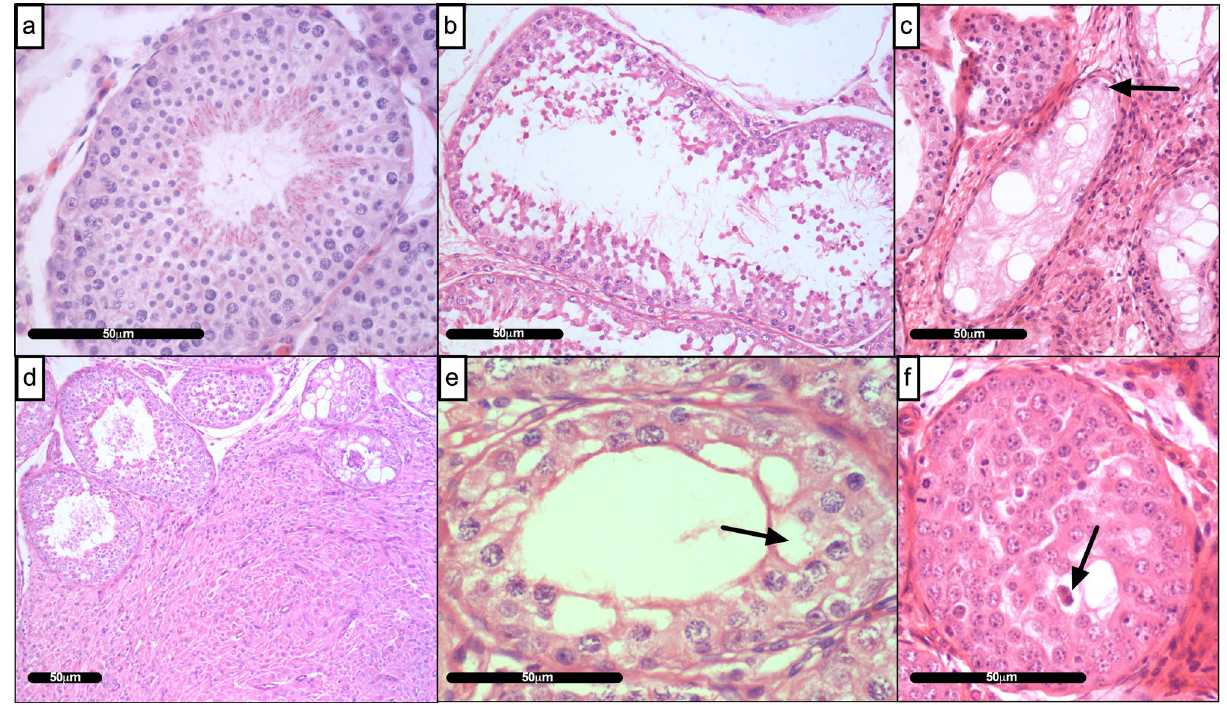
Figure 1. Histopathological features of dog testes. ( a ) Normal seminiferous tubule ( b ) Degeneration of the interstitium—Luminal cellular debris within tubule; ( c ) Sertoli cell only tubule; ( d ) Interstitial fibrous hyper-